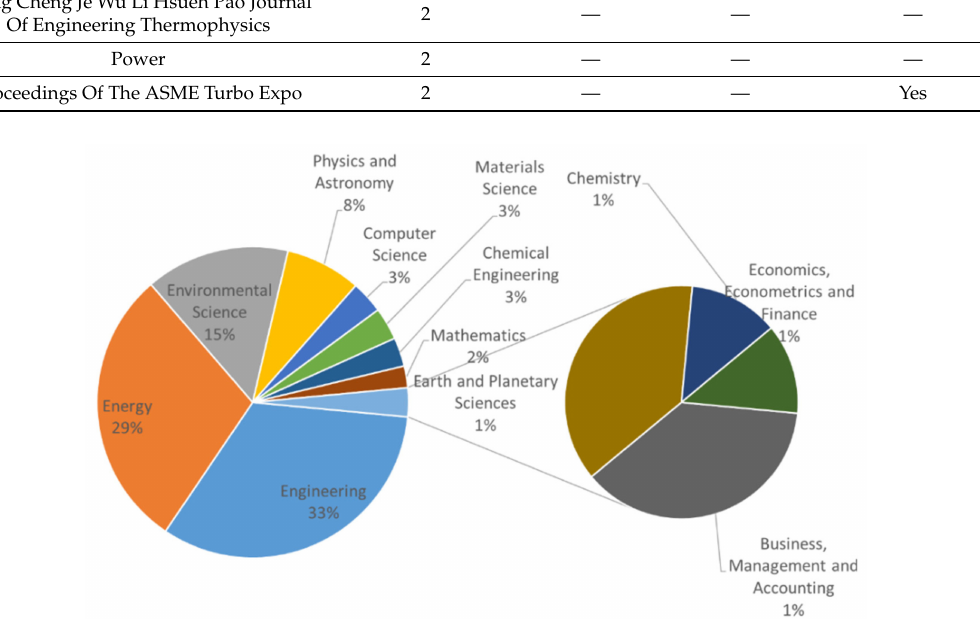
Figure 6. Percentage distribution of the subject area of the